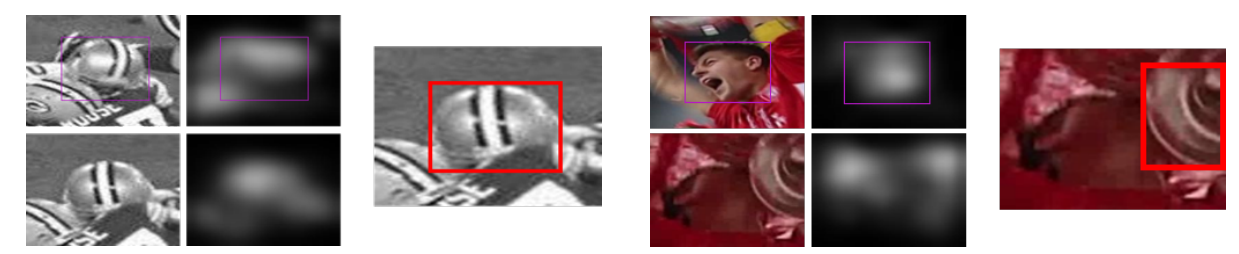
Figure 9. Illustration of good tracking with (a) significant illumination change, (b) texture and edge change, (c) deformation and out plane rotation, (d) fast motion and motion blur.